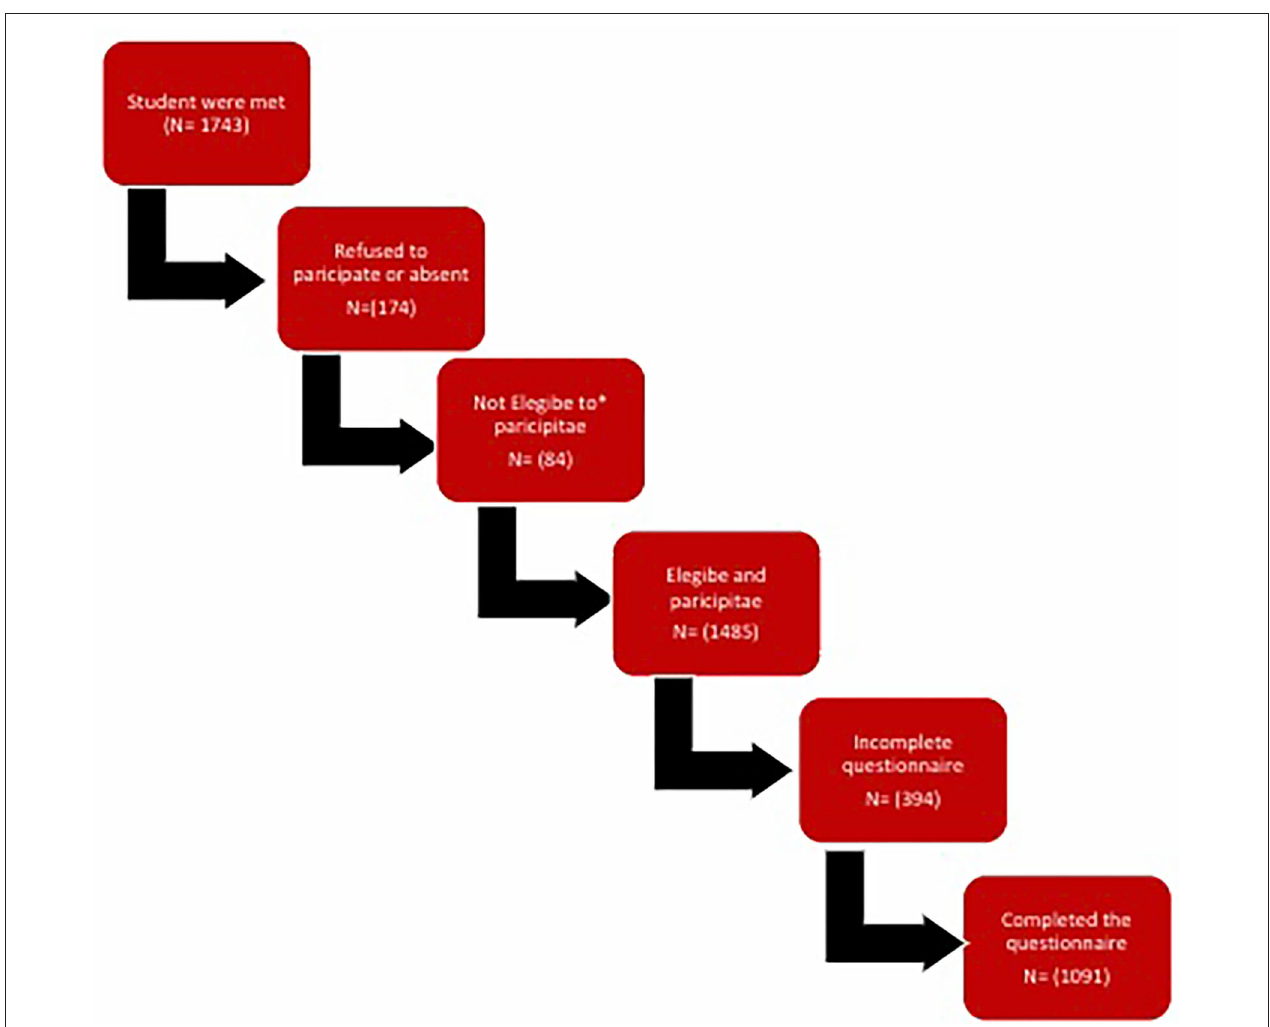
FIGURE 1 | Flow chart of participants. *Non Kuwaiti, Kuwaiti living in Kuwait less than 1 year, has medical or neurological disorder, or Children younger than 7